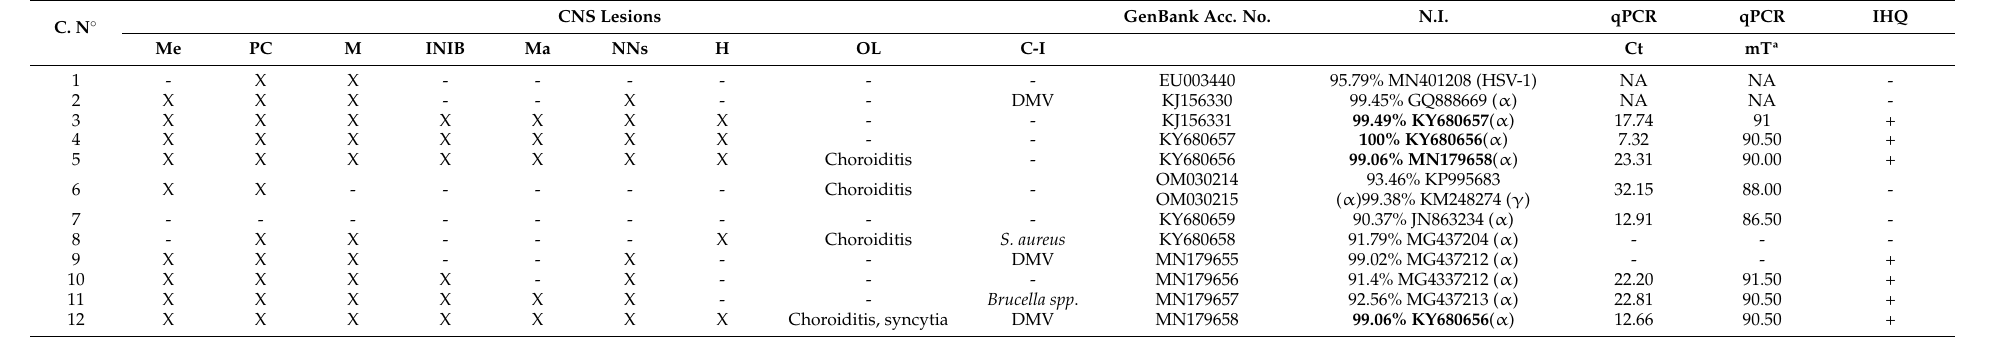
Table 2. Classical central nervous system (CNS) lesions associated with the presence of α -HVs consisted of meningeal mononuclear cell infiltrates (Me), lym- phoplasmacytic perivascular cuffs (PC), diffuse microgliosis (M), intranuclear inclusion bodies (INIB), Malacia (Ma), neuronal necrosis and associated focal neurophagic nodules (NNs), and haemorrhages (H). OL: other lesions; C-I: co-infections; N.I.: nucleotide identity (with highest query cover); HSV-1: herpes simplex human type 1; α : alphaherpesvirus; γ : gammaherpesvirus; qPCR: quantitative polymerase chain reaction; Ct: threshold cycle; mTª: melting temperature; IHQ: immunohistochemistry; NA: not applicable. Highest nucleotide identities between sequences from our study are indicated in